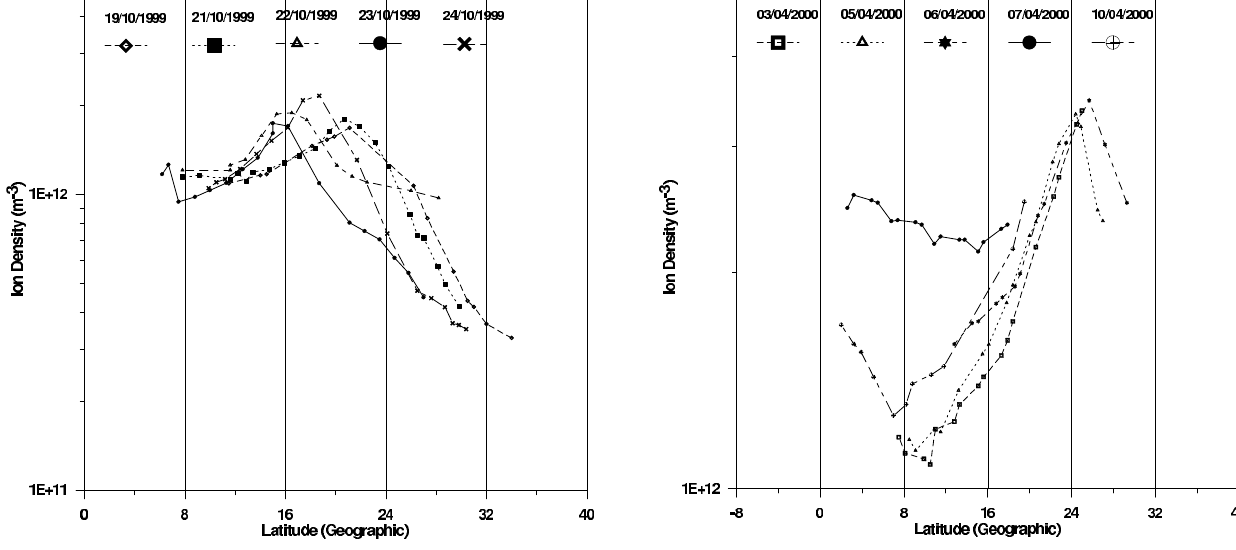
Fig. 5. Latitudinal variation of ion density observations made by the SROSS-C2 satellite during the period of storm III. The longitude range covered by each pass is given in Table 2.